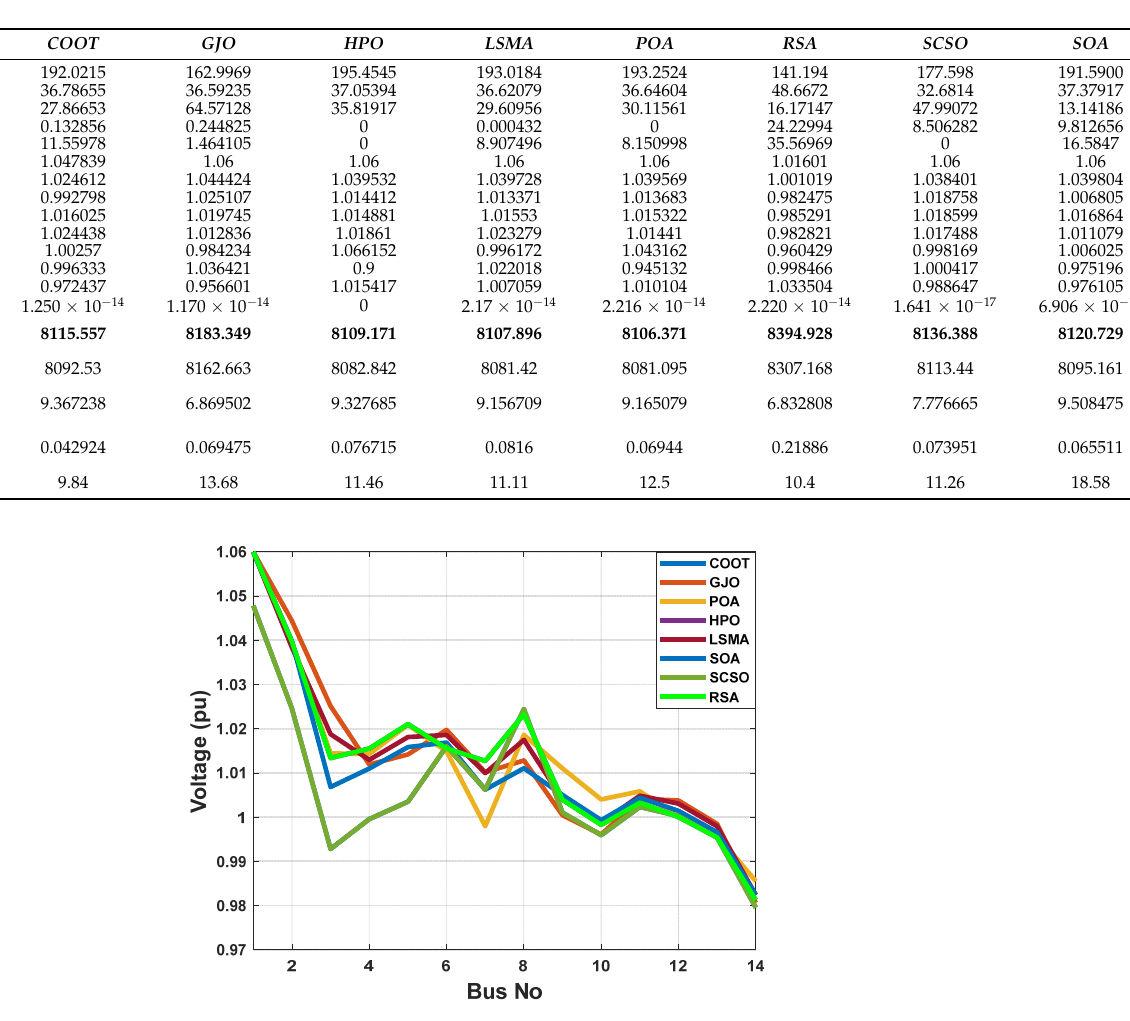
Table 5. Optimal control variables for the IEEE 14-bus test system for minimizing multi-objective function without emissions.